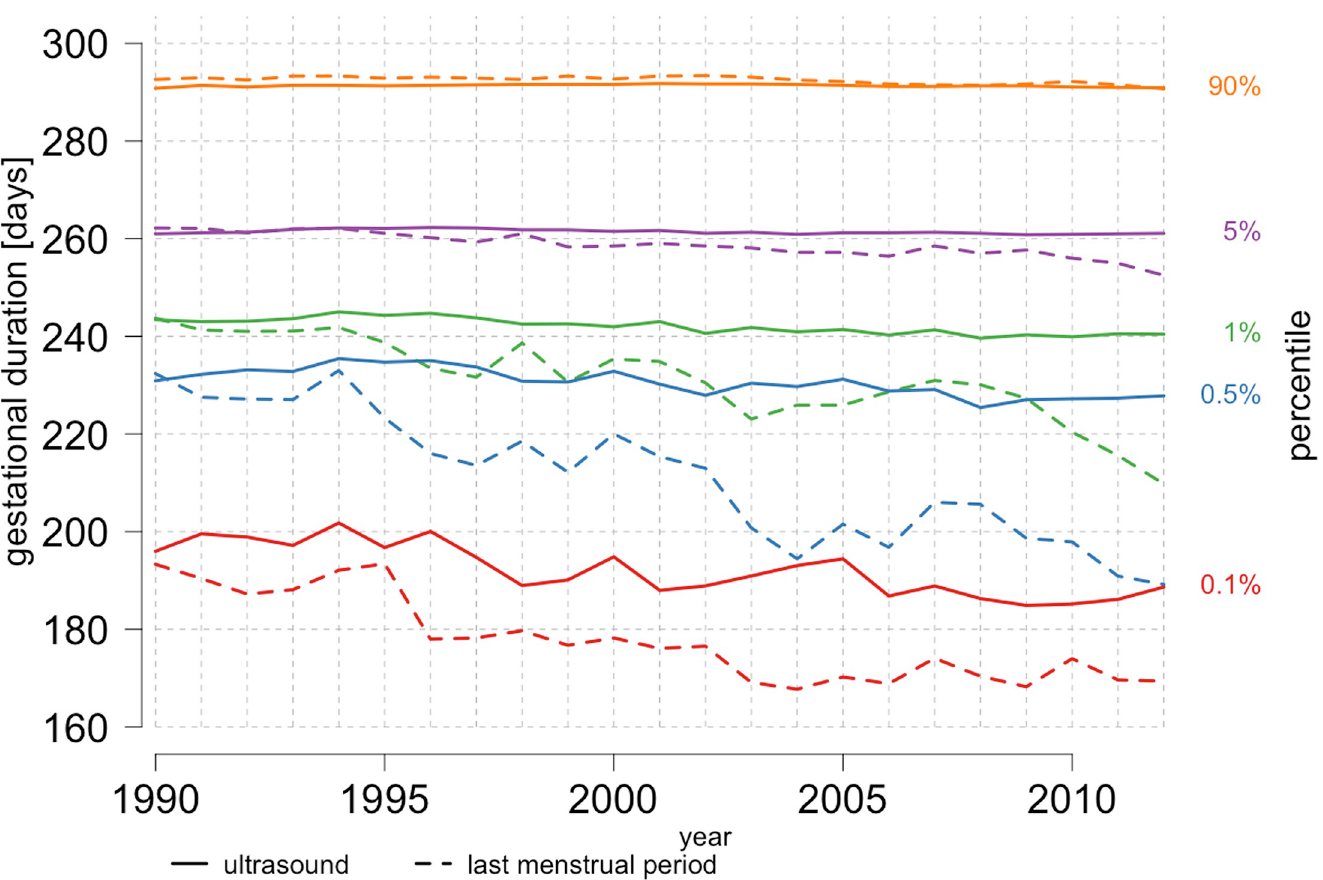
Fig 4. Distribution of gestational duration in women with spontaneous-onset deliveries, Swedish Medical Birth Register, 1990–2012. Temporal changes in the gestational duration percentiles: 0.1 th , 0.5 th , 1 st , 5 th , 90 th , with regard to estimation method, LMP-based (dashed line) or ultrasound-based (solid line); percentiles are respectively marked with different colors. The left-hand y-axis indicates gestational duration in days and the right-hand y-axis indicates percentiles. Sample sizes: pregnancies with LMP-based duration estimate: n = 272 416; pregnancies with ultrasound-based duration estimate: n = 1 551 133.